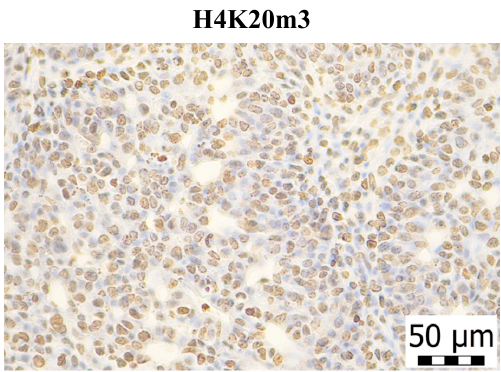
Figure 6. Representative images of expression of caspase-3, Bax, Bcl-2, Ki67, VEGFA, VEGFR-2, MDA, CD24, CD44, ALDH1A1, EpCam, H3K4m3, H3K9m3, H4K20m3, and H4K16ac in rat carcinoma tissue